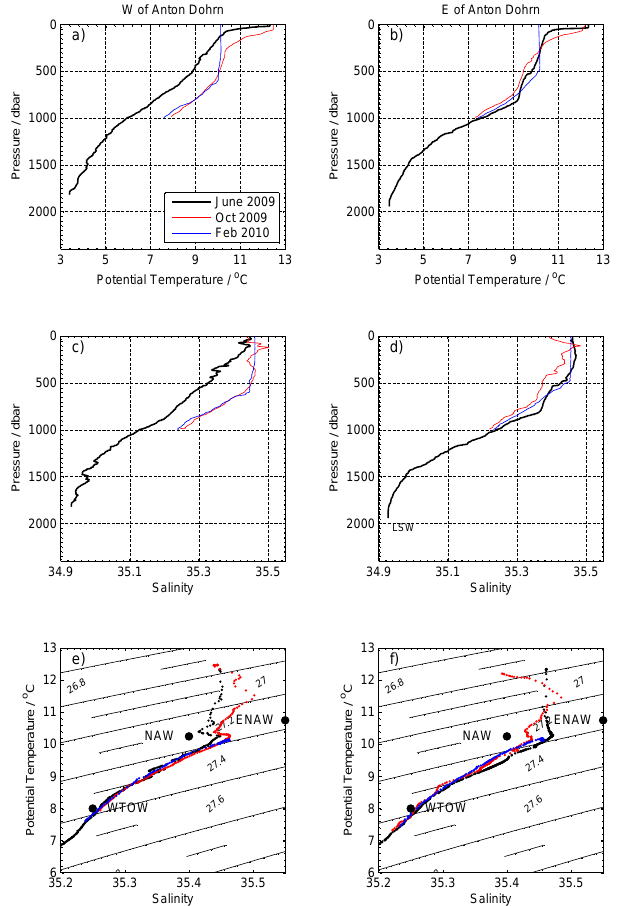
Figure 3. Temperature and salinity profiles and θS plots either side of the Anton Dohrn Seamount from cruise D340 (full depth, black) and Mission 1 (to 1000m, red and blue). Glider data are averages of the up and down casts. For positions, see Fig.